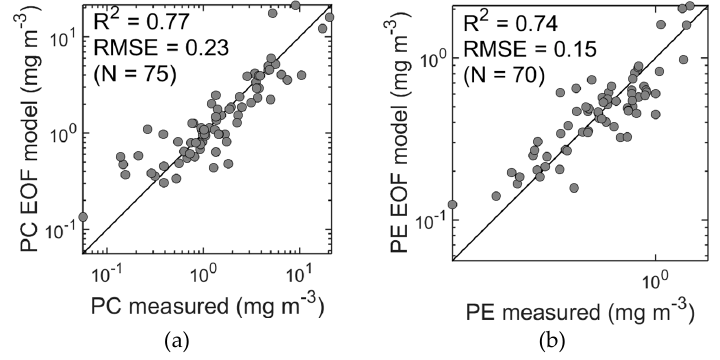
Figure 9. Comparison between phycobilin pigment (phycocyanin ( a ) and phycoerythrin ( b )) concentrations measured in situ and derived from the EOF